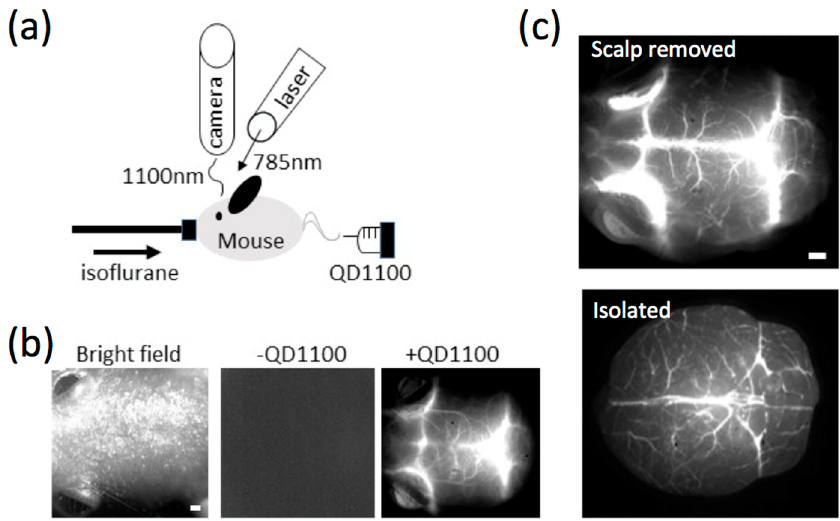
Figure 4. ( a ) Experimental setup for NIR fluorescence imaging of cerebral blood vessels. An anesthetized mouse was administered QD1100 in a caudal vein. An optical laser (785 nm wavelength) was used as an excitation light source, and NIR fluorescence was detected with an InGaAs camera; ( b ) Imaging of a mouse head. Bright field image ( left ), NIR fluorescence image without QD administration ( middle ), and the NIR fluorescence image with QD administration ( right ). Scale bar: 1 mm; ( c ) NIR fluorescence images of cerebral blood vessels. Upper: fluorescence image after scalp removed, lower: fluorescence image after isolation. Scale bars: 1 mm.